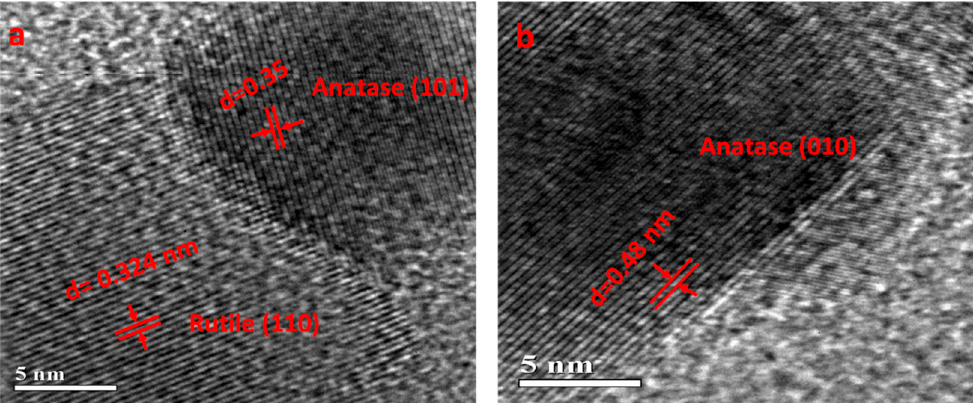
Figure 3. HRTEM images of ( a ) P25 and ( b ) T-{010}.